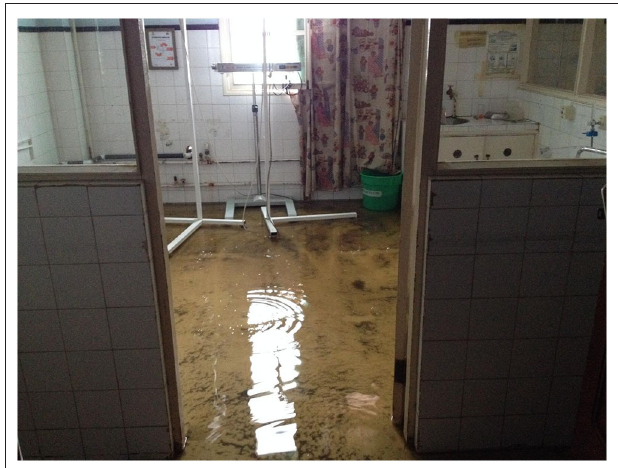
FIGURE 3 | The neonatal intensive care unit the day after the